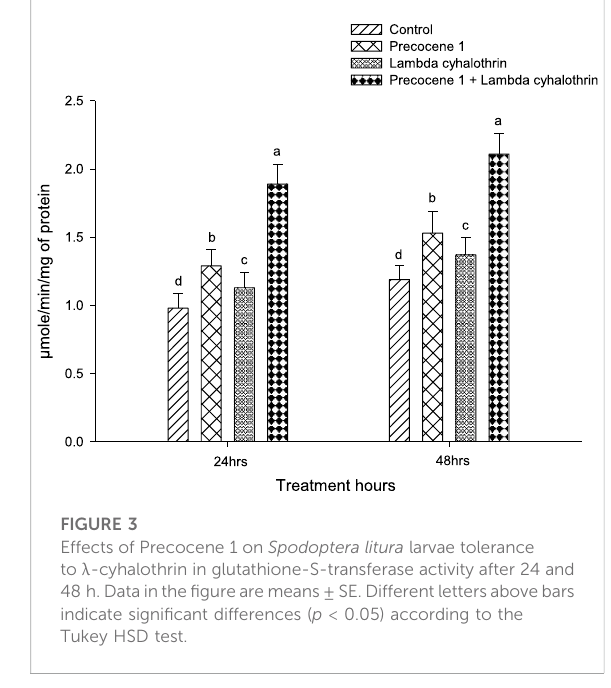
FIGURE 1 Effects of Precocene 1 on Spodoptera litura larvae tolerance to λ -cyhalothrinin α -esteraseactivityafter24and48 h.Datainthe fi gure are means ± SE. Different letters above bars indicate signi fi cant differences ( p < 0.05) according to the Tukey HSD test.